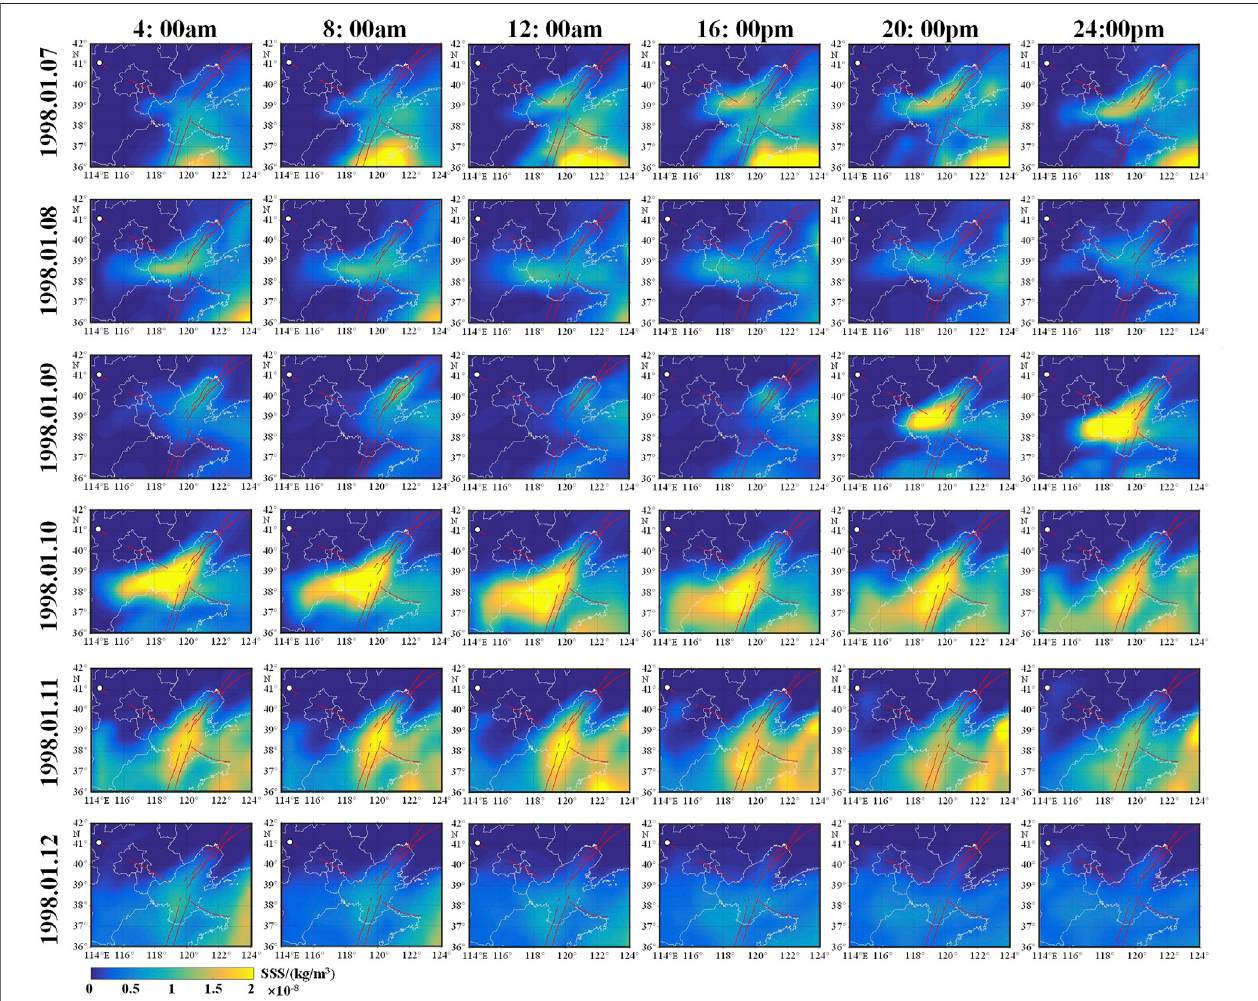
FIGURE 7 | The change of SSS concentration over Bohai Sea from 7 to 12 January